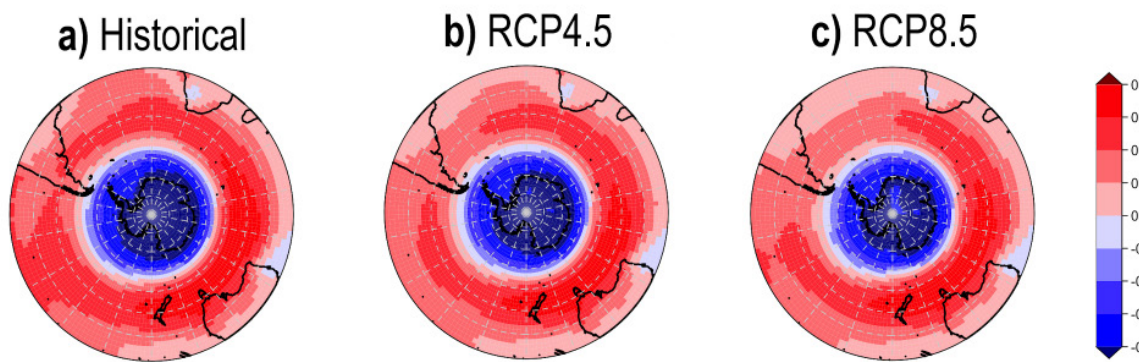
Figure 3. GW99 SAM index regressed onto SLP monthly anomalies. a) Historical, b) RCP4.5, and c) RCP8.5. Values correspond to the correlation coefficient and are nondimensional.